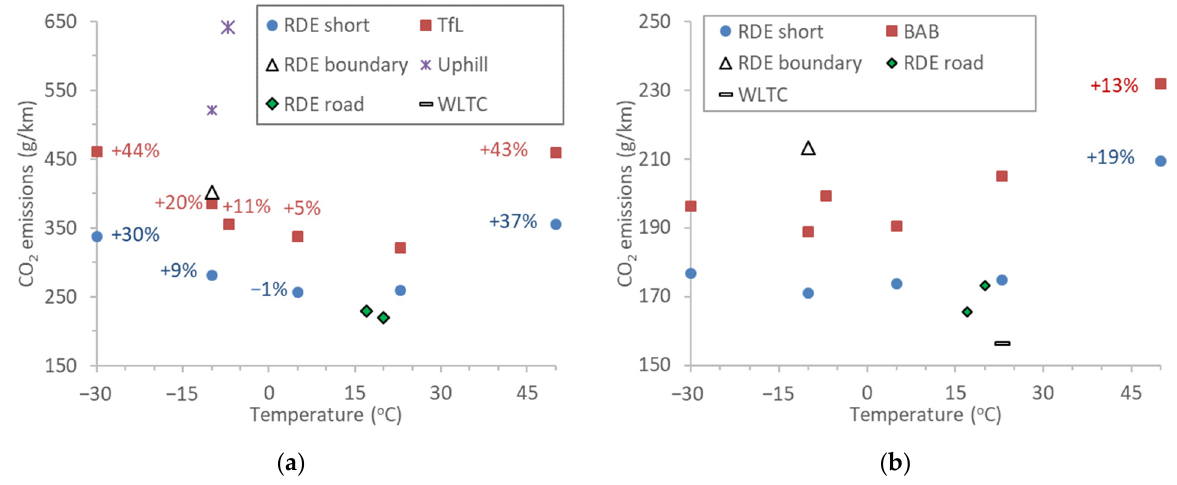
Figure 3. CO 2 emissions of in function of ambient temperature: ( a ) urban cycles (TfL, uphill) or urban parts of the rest cycles (RDE short, RDE boundary, RDE road, and WLTC low and medium phases); ( b ) motorway cycle (BAB) or motorway parts of the rest cycles (RDE short, RDE boundary, RDE road, and WLTC extra high phase).